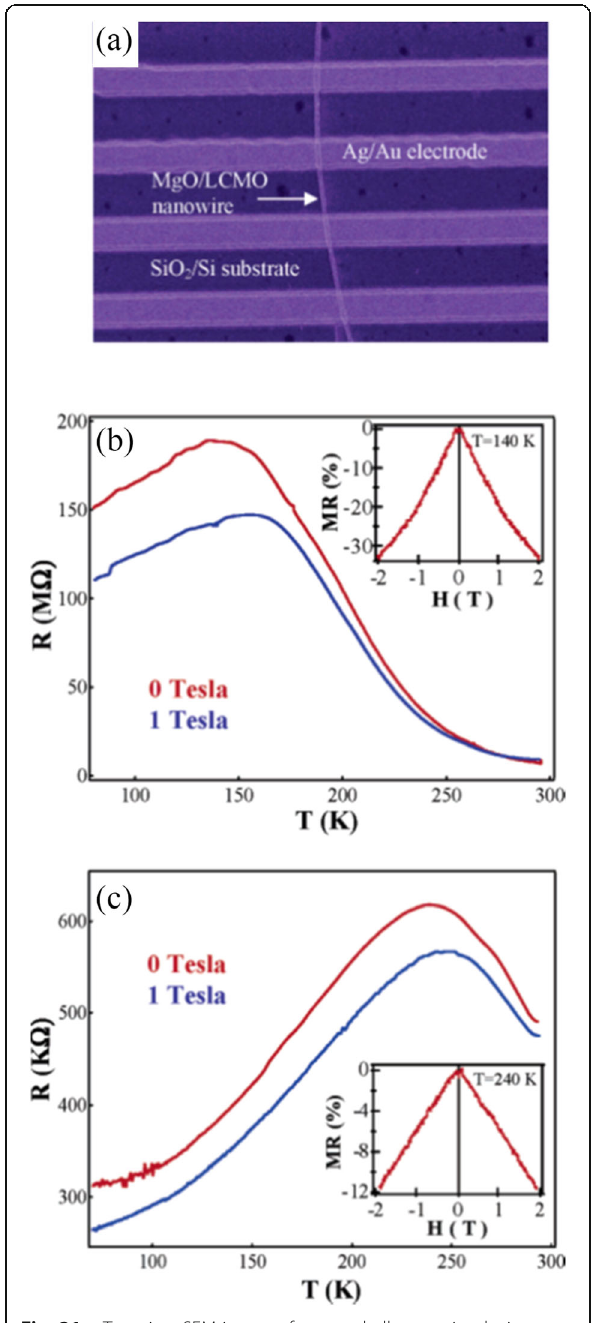
Fig. 31 a Top view SEM image of a core-shell nanowire device showing four Ag/Au contact electrodes with even spacing. b , c Four-probe resistance ( R ) vs. temperature ( T ) curves measured under two different magnetic fields B = 0 T (red) and B = 1 T (blue), with b MgO/LaCaMnO 3 (LCMO) nanowire and c MgO/LaSrMnO 3 (LSMO) nanowire. Insets of panels b , c magnetoresistance (MR) recorded at temperature T = 140 K for panel b and T = 240 K for panel c , respectively. Reproduced with permission of